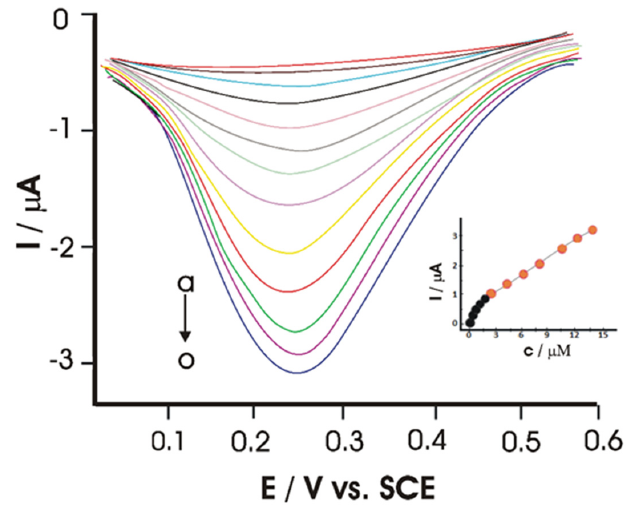
Figure 7. Differential pulse voltammograms at UiO-66-NH 2 /TiO 2 /GCE for different concentrations of chlorogenic acid in pH 6.0 PBS (from a to o) 0.01, 0.03, 0.05, 0.07, 0.1, 0.3, 0.5, 0.7, 1.0, 3.0, 5.0, 7.0, 10, 13 and 15 μ mol·L − 1 . The inset shows the relationship between the peak current and the chlorogenic acid concentration. Adapted from [61].